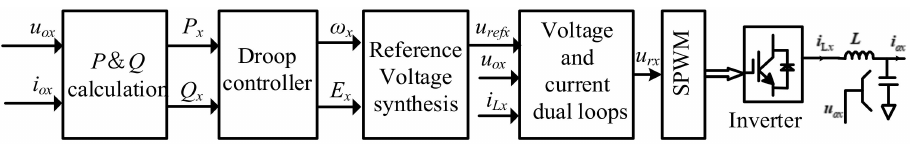
Figure 3. General block diagram of the control scheme for the parallel